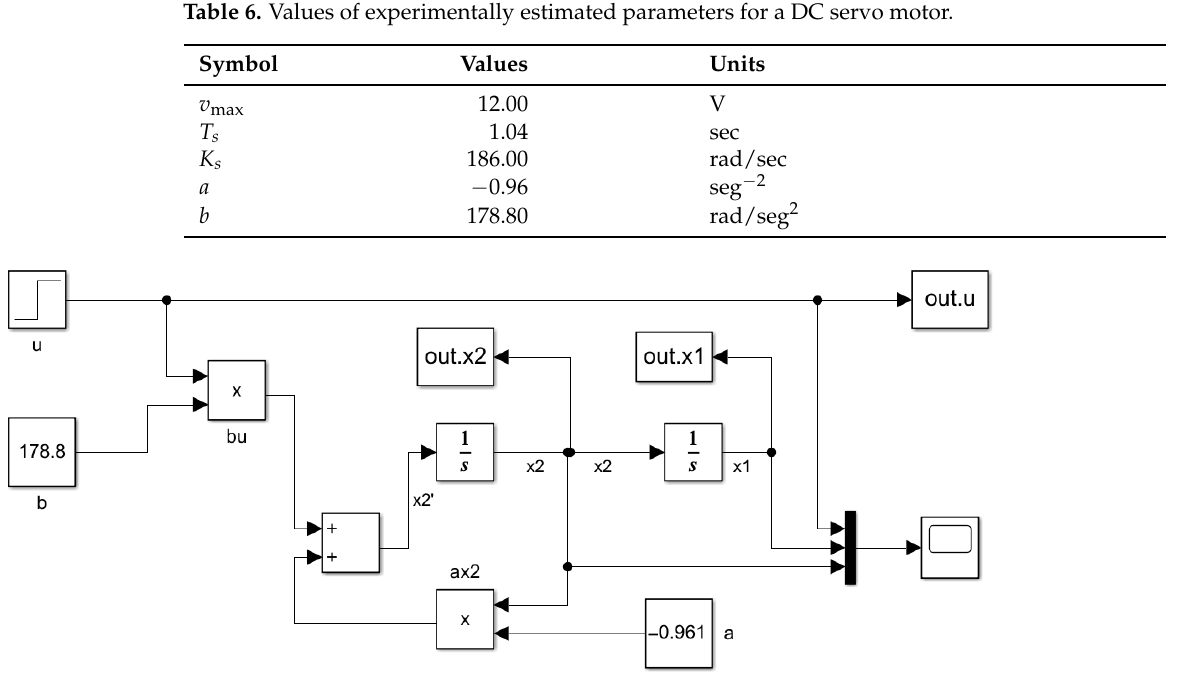
Figure 3. Open-loop Simulink model of the DC servo motor.